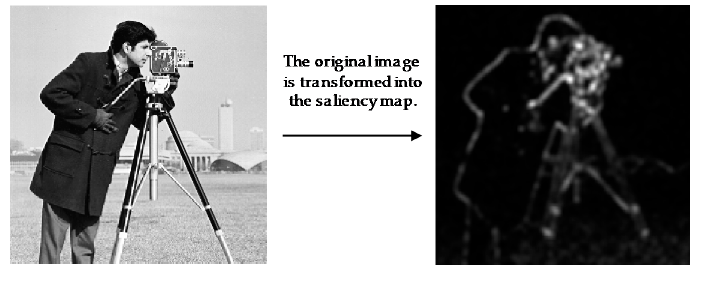
Figure 2. Saliency map derivation: